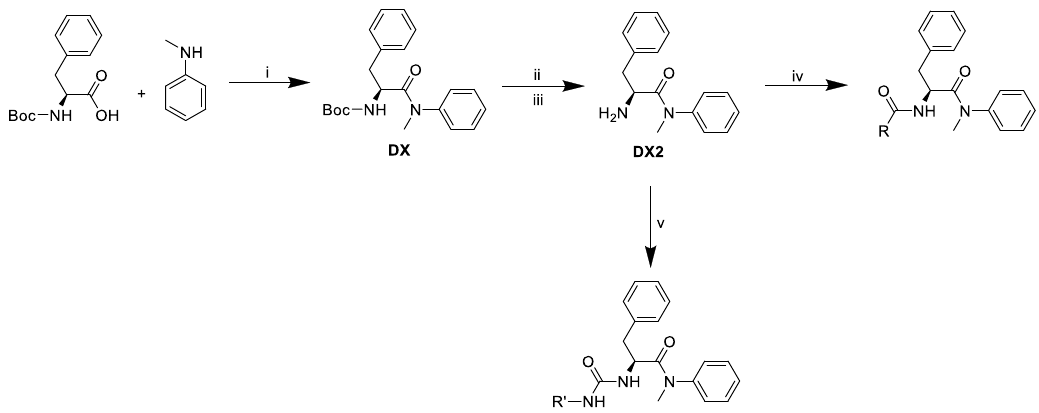
Figure 8. Synthetic pathway of final derivatives. i: T3P ® , pyridine, ii: trifluoroacetic acid, iii: Dowex